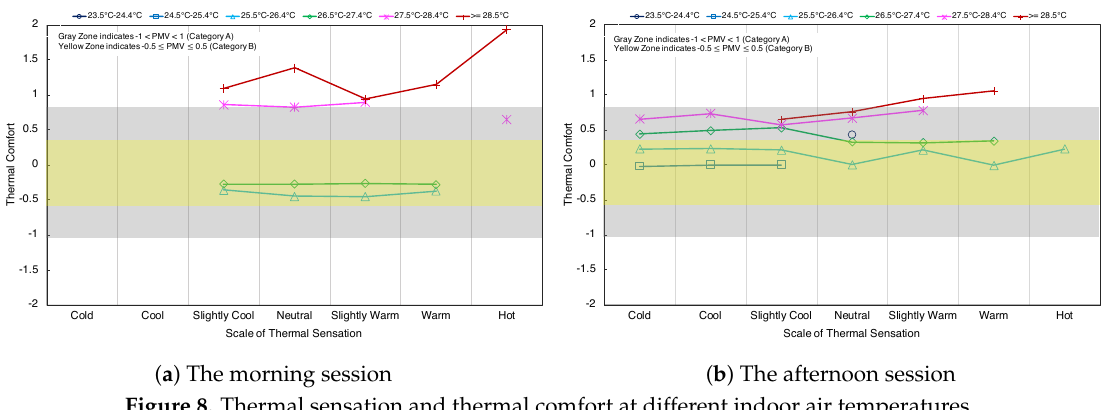
Figure 8. Thermal sensation and thermal comfort at different indoor air